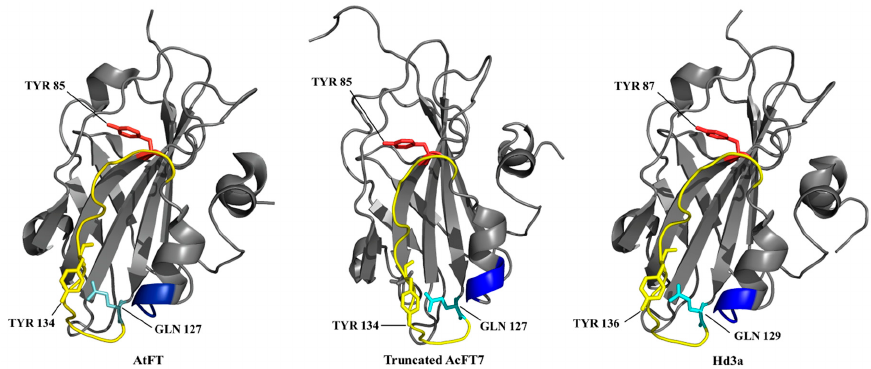
Figure 2. Predicted homology protein model of truncated AcFT7 in comparison to AtFT ( Arabidopsis ; 1AWF) and Hd3a (rice; 3AXY_A) protein. The external loop segment B is represented in yellow and segment C (XYN triad) in blue color. The crucial residues Tyr (red), Gln (cyan), Tyr (yellow in Segment B) are shown as sticks.